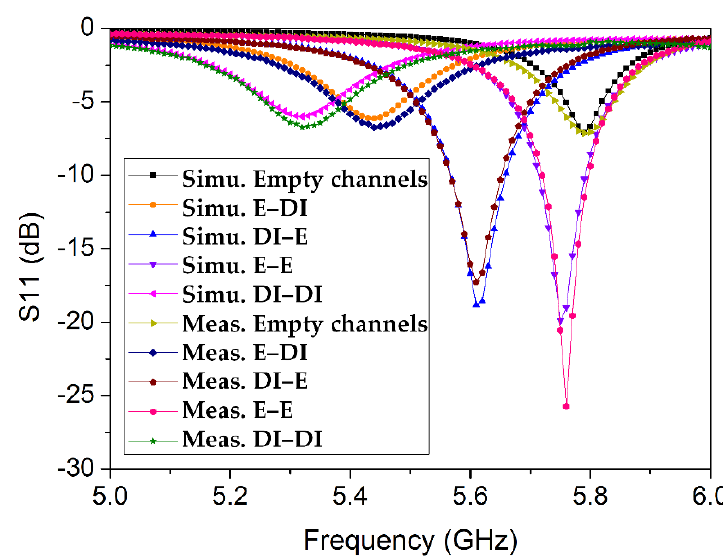
Figure 13. Comparison of the return-loss values obtained from the simulation and measurement for all possible combinations of ethanol and DI water and for empty channels. Table 2. Comparison between the simulation and measurement results after the loading of microfluidic channels. The resonant frequencies and return-loss measurements are provided, corresponding to empty channels and the four possible combinations of ethanol and DI water.